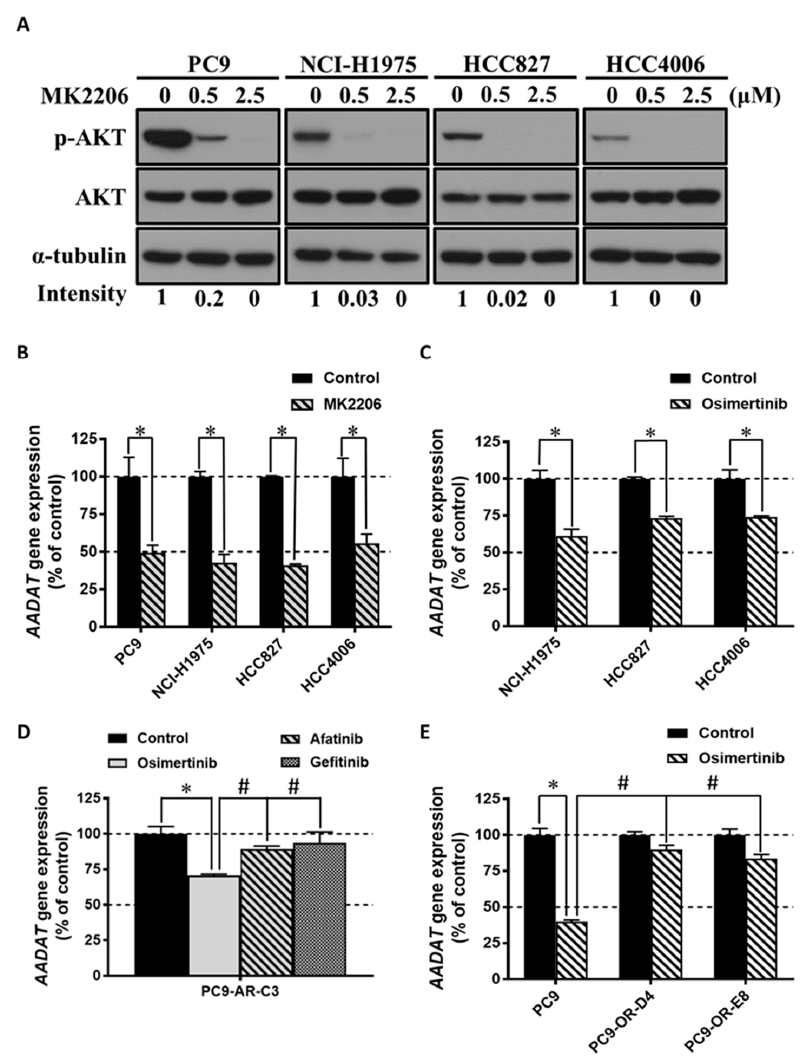
in PC9-AR-C3 cells (Figure 6D), and the effects on the expression of AADAT under treatment with EGFR-TKI were consistent with the results of survival (Figure 2A). We also found that cell lines under lysine reduction, and the results showed that this treatment in along with downregulation of AADAT expression by osimertinib treatment could only be observed lysine reduction (55, 27.5, and 13.75 µ M) can enhance osimertinib-induced cytotoxicity in a in parental PC9 cells but not in the osimertinib-resistant clones (PC9-OR-D4 and PC9-OR- concentration-dependent manner in EGFR -mutant cells (Figure 7E for PC9, Figure 7F for E8) (Figure 6E). These results demonstrate that AADAT is a downstream target of EGFR– NCI-H1975, Figure 7G for HCC827, and Figure 7H for HCC4006). AKT signaling in EGFR -mutant NSCLC cells.